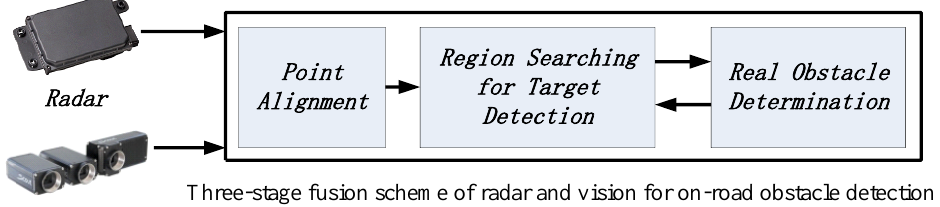
Figure 1. Fusion scheme of MMW radar and a monocular vision